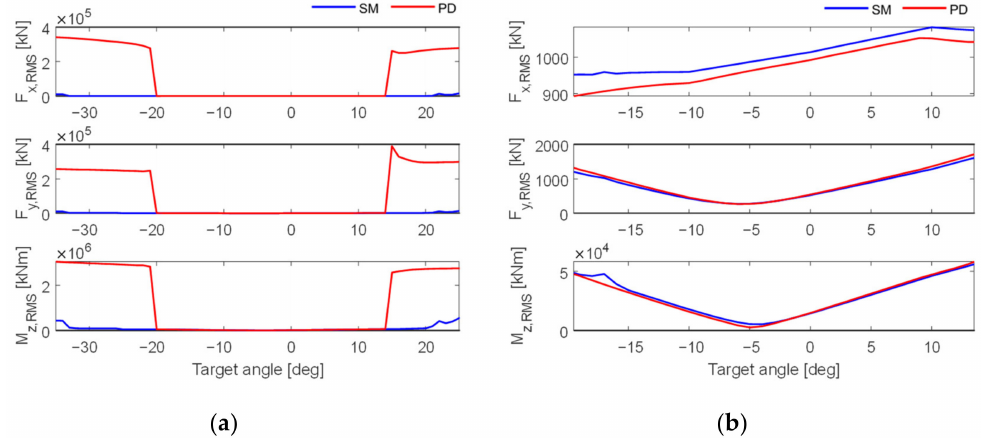
Figure 18. RMS values of the control forces of the FPSO vessel in steady-state condition: ( a ) Target angle between − 35 to 25 ◦ and ( b ) Target angle between − 20 to 14 ◦ .